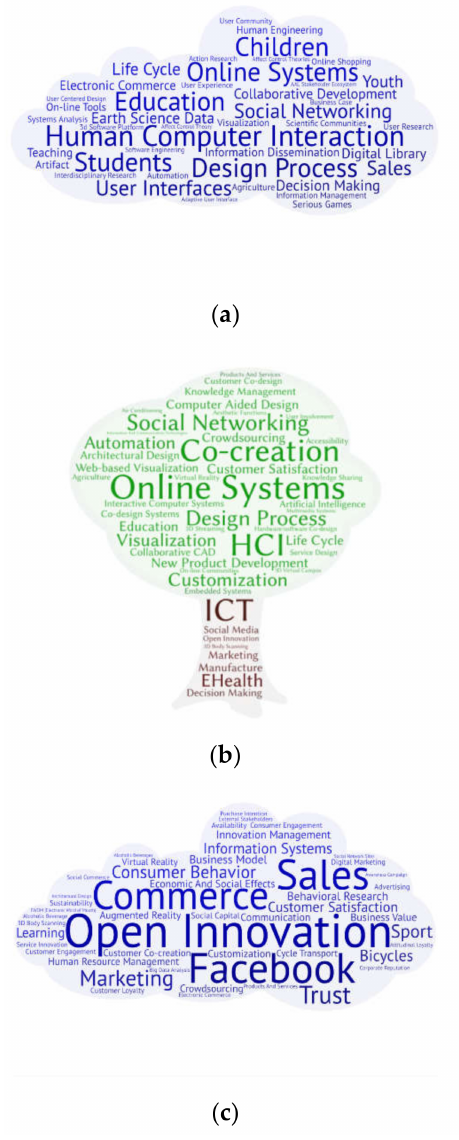
Figure 7. The word cloud of main keywords related to web-based and product design in participatory design, co-design, and co-creation. ( a ) Keywords of web-based product participatory design. ( b